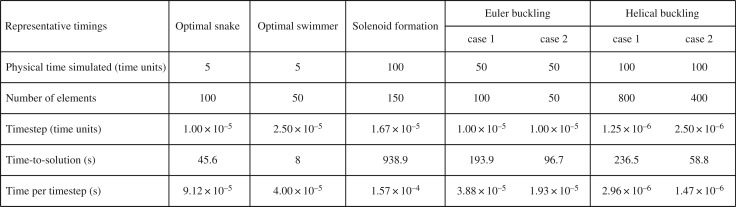
Timings for various representative simulations. The time-to-solution values reported correspond to an average over 10 measurements for the same study case.